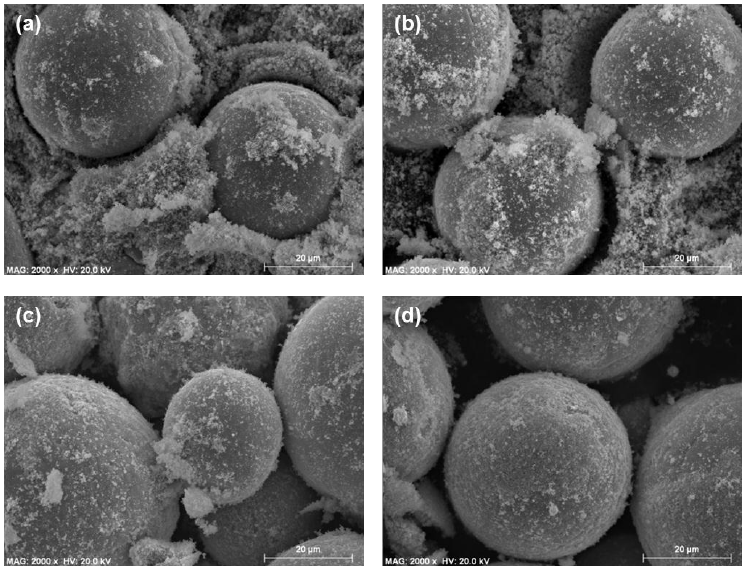
Figure 6. SEM images of the RF plasma-treated stainless steel 316L powders when the distance from the plasma torch to the feeding nozzle is ( a ) 0, ( b ) 2, ( c ) 4.5 and ( d ) 6.5